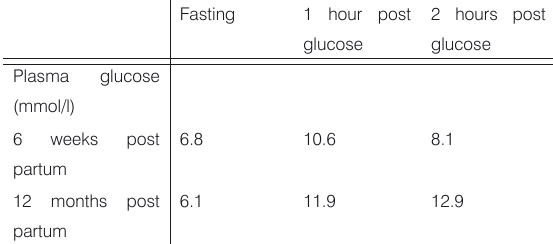
Table 4. Two subsequent OGTTs undertaken at 6 weeks and 12 months post Fasting